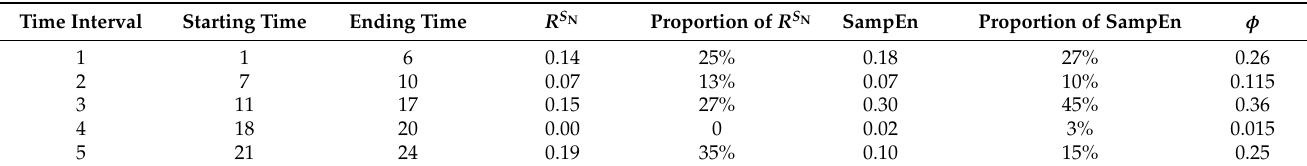
Table 3. Time-series characteristic analysis of the net load for 20